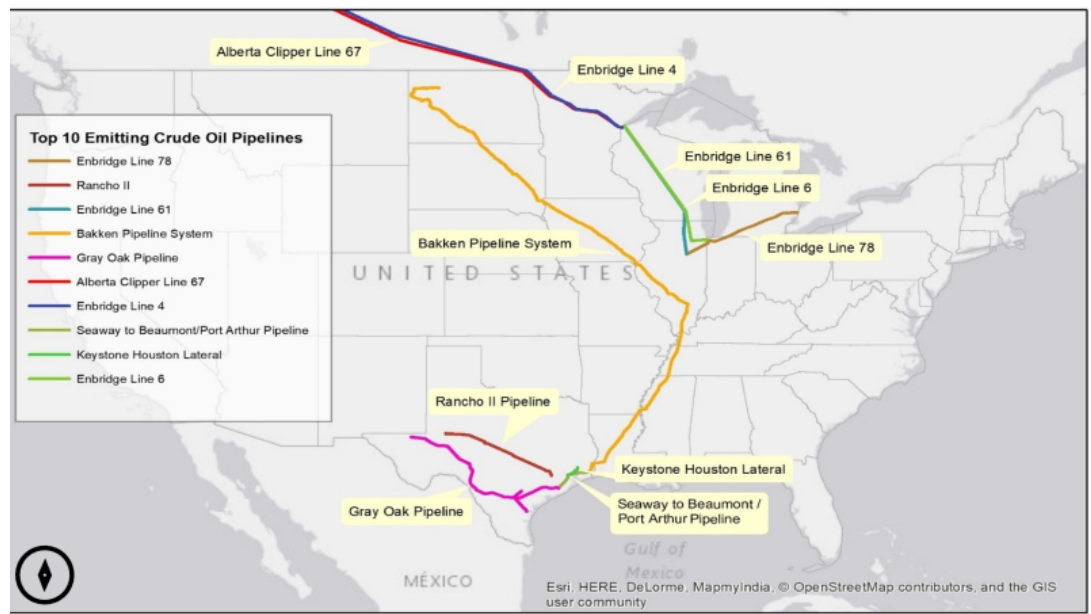
Figure 16. Map of Top CO 2 Emission Bottlenecks- Oil Pipelines in the United States (Generating using OpenStreetMap).